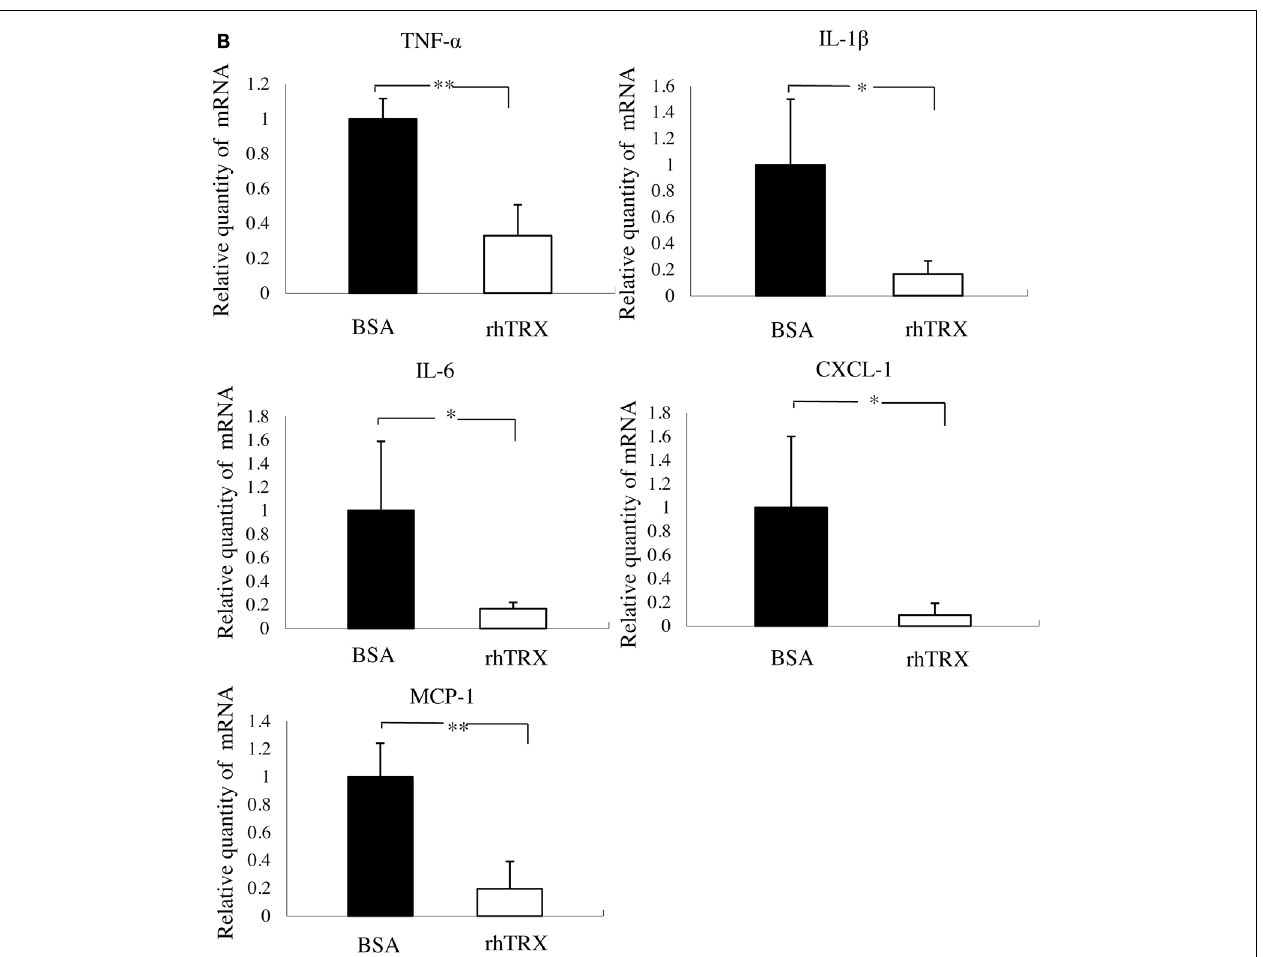
IL-6, CXCL-1, and MCP-1 were verified by real-time RT-PCR.The mRNA expression was normalized to GAPDH.The mRNA expression levels were determined relative to control sample from BSA treatment group.The mRNA expression ofTNF- α , IL-1 β , IL-6, CXCL-1, and MCP-1 was significantly suppressed by the topical application of rhTRX (* P < 0.05, ** P < 0.01).Values are mean ± SD of five mice per group (Student t -test,Wilcoxon signed-rank